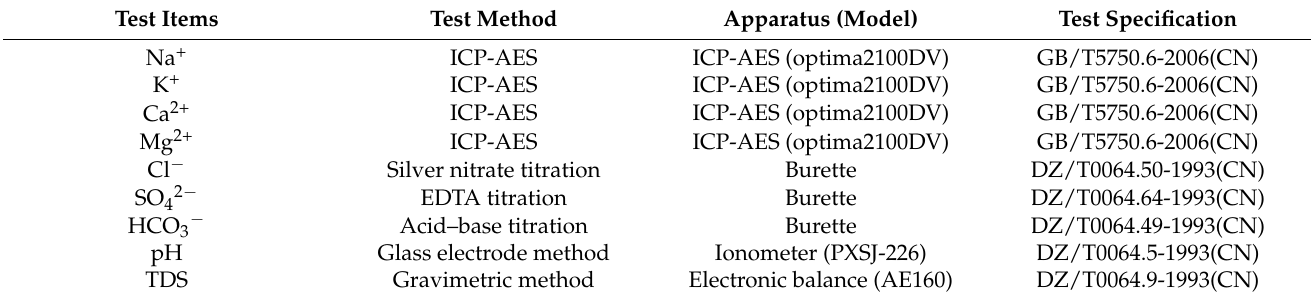
Table 1. Test items and methods of water chemical composition.